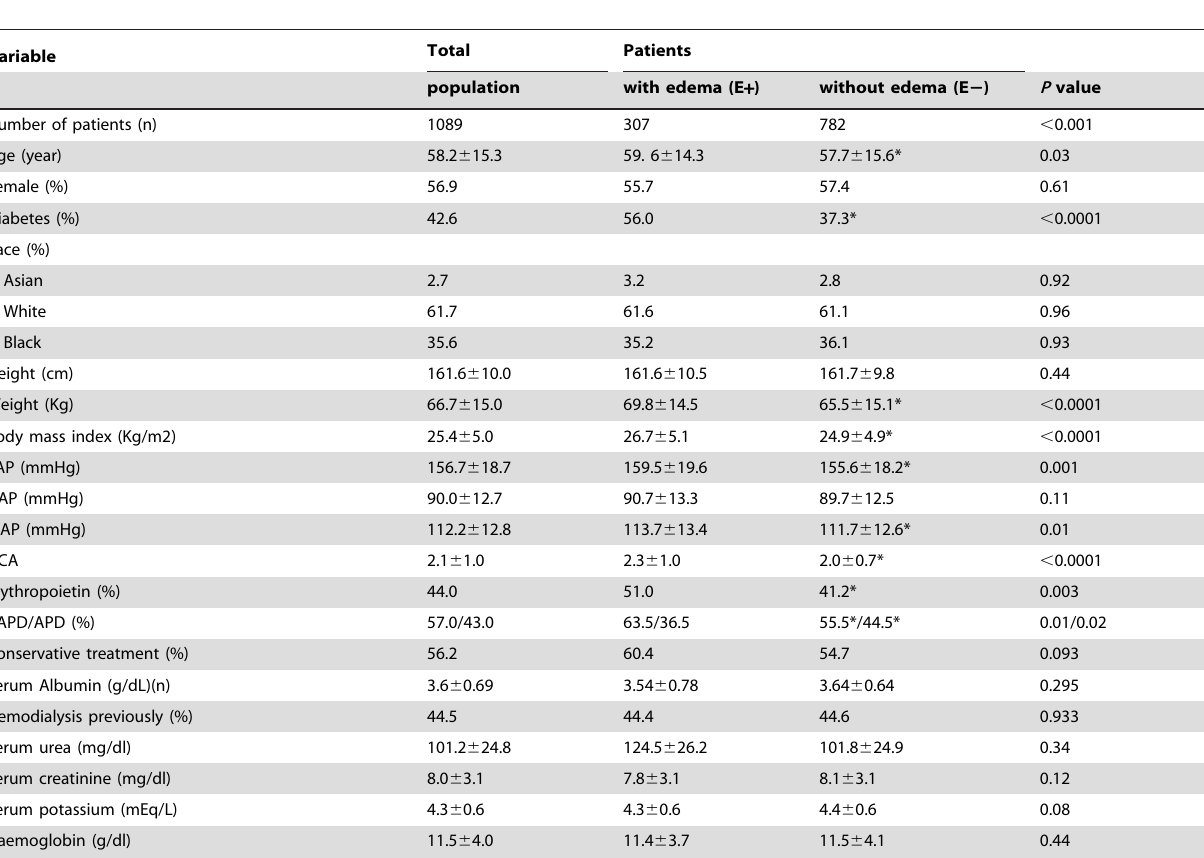
Table 1. Demographic, clinical and laboratory characteristics of patients at the baseline evaluation.